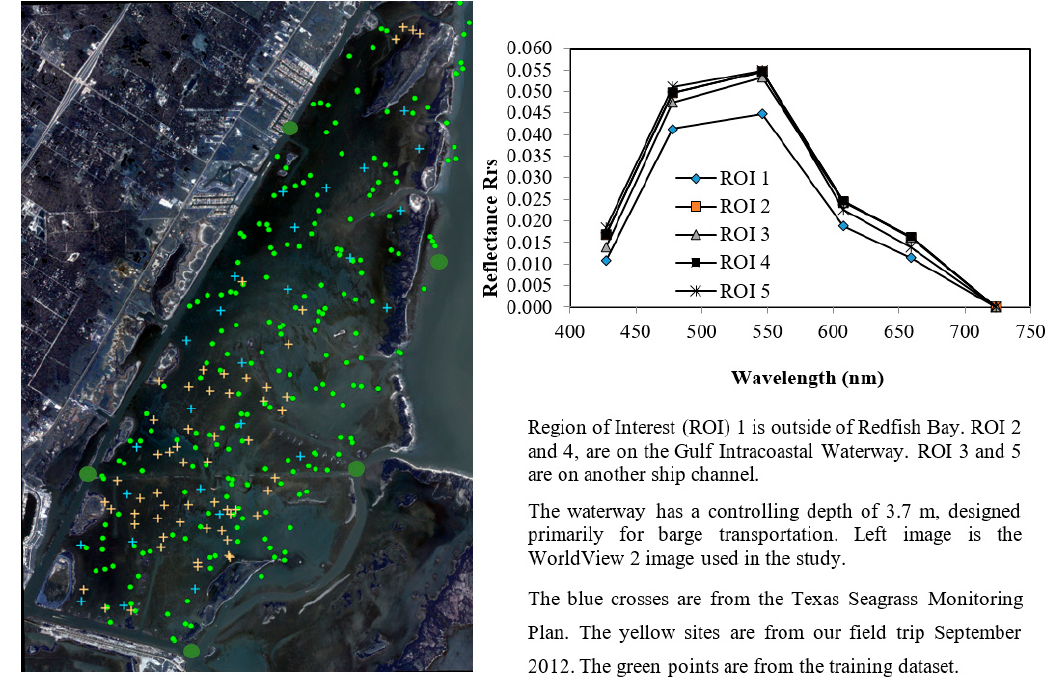
Figure 3. The validation data and five deep water sites and their spectrum. Table 2. Coefficients for water column correction ( a w ( λ ) and 𝑏 (cid:3029)(cid:3050) (𝜆) are pure-water absorption and backscattering coefficients. M ( λ ) is the coefficient defined by Austin and Petzold. 𝑎 ( λ ) is the total absorption coefficient. 𝑏 (cid:3029) (𝜆) is the backscattering coefficient).